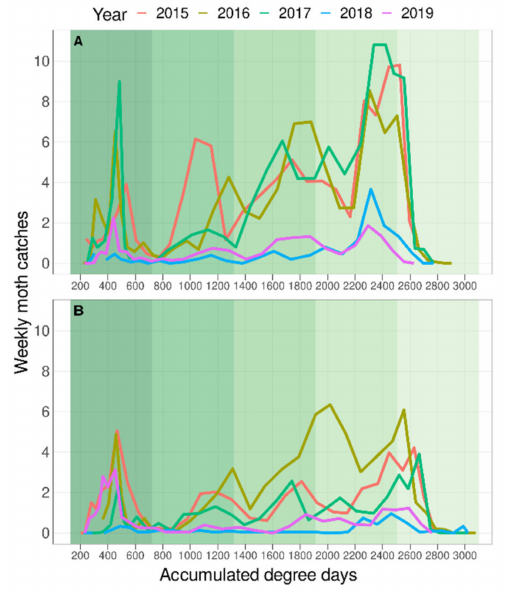
Figure 4. Mean weekly moth catches in the Girona province plotted against DD for each area and year. ( A ) Alt Empord à and ( B ) Baix Empord à , both of Girona province. Background colours indicate the predicted generation range of the phenology model [18] plus 60 DD for feeding on apples (595 DD in total) as reported by Myers et al. [33] and Yang et al.